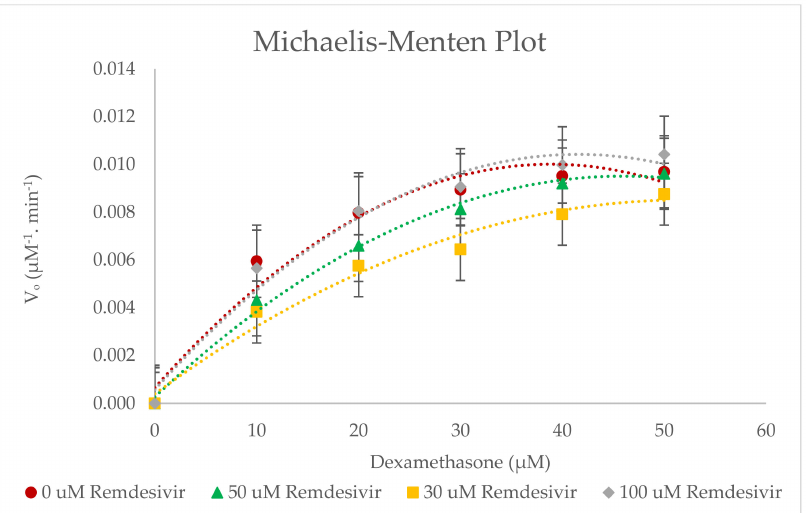
Figure 8. Michaelis − Menten plot for the inhibition of CYP3A2 − catalysed dexamethasone 6 − hydroxylation by remdesivir (0 − 100 µ M). The polynomial function of order 2 was used to fit the curves. Values are expressed as the average of triplicate